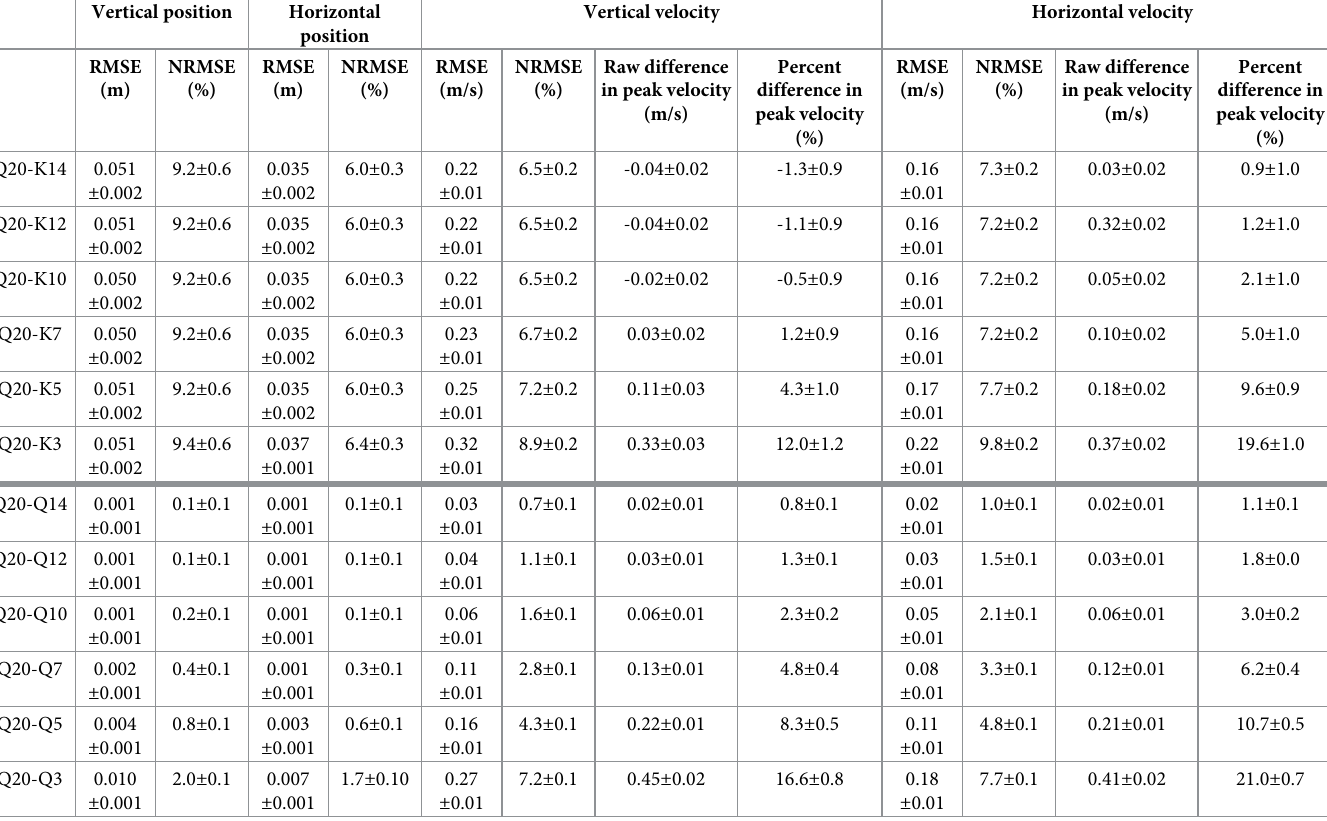
Table 1. Errors between position and velocity signals from Qualisys and Kinovea from different cut-off